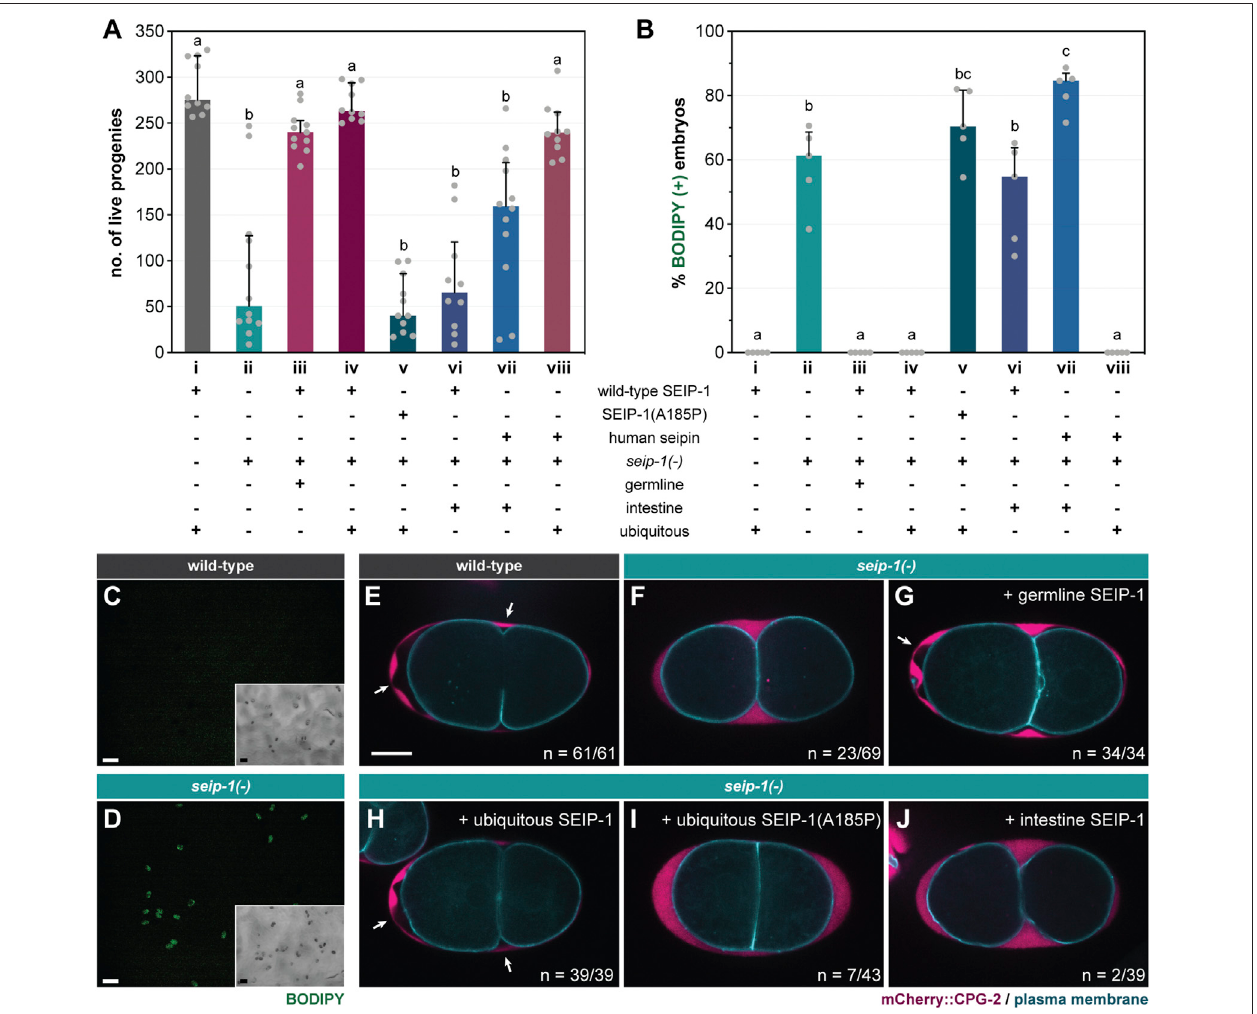
FIGURE 1 | SEIP-1 is required for eggshell integrity of C. elegans . (A) The total number of live progenies from individual animals. At least 10 animals of each genotypewerescored.Medianwithinterquartilerangeisdisplayed(appliestoallsubsequentbarchartsandscatterplots).Groupsthatdonotsharethesamelettersare signi fi cantly different (ordinary one-way ANOVA with Turkey ’ s multiple comparisons test, p < 0.01). (B) As in (A) , but with the percentage of BODIPY-stained embryos quanti fi edinade fi nedtimewindow.Fiveindependentbiologicalsampleswerescored,eachstemmingfromfour1-day-oldadults.Fordetailedexperimentalsetup, refertoMethodsandMaterials. (C) Stainingofembryoslaidby1-day-oldwild-type(WT)adultswiththe fl uorescentBODIPY493/503dye.ThedyefailedtopenetrateWT eggs as shown in the fl uorescence image. Inset, the corresponding bright fi eld image. Scale bar = 100 μ m. (D) As in (C) , but with embryos laid by seip-1(tm4221) mutants (referred to as seip-1(-) in all subsequent fi gures). The penetration and subsequent accumulation of the BODIPY dye in a subset of embryos is shown. (E) Visualization ofthepermeability barrier(PB)inarepresentative 2-cellstage embryoisolatedfrom a1-day-oldWT adult. PBdelimits theperi-embryonic space (PES)from the perivitelline space (PVS). White arrows point to PES [non fl uorescent region between PVS, marked by endogenous mCherry::CPG-2 ( hj340 ), and the plasma membrane, marked by GFP::PH(PLC1 δ 1) ( itIs38 )], which is absent if PB formation is impaired. A single focal plane is shown. mCherry and GFP are pseudocolored magenta and cyan, respectively. The schematic layout of the eggshell is shown in Supplementary Figure S1A . n = number of embryos with PES/total number of embryos examined. Scale bar = 10 μ m. (F) As in (E) , but with the seip-1(-) mutant. (G – J) As in (F) , but with the transgenic expression of germline SEIP-1 ( hjSi502 ), ubiquitous SEIP-1 ( hjSi189 ), ubiquitous SEIP-1 (A185P) ( hjSi541 ), or intestinal SEIP-1 ( hjSi3 ) as indicated.